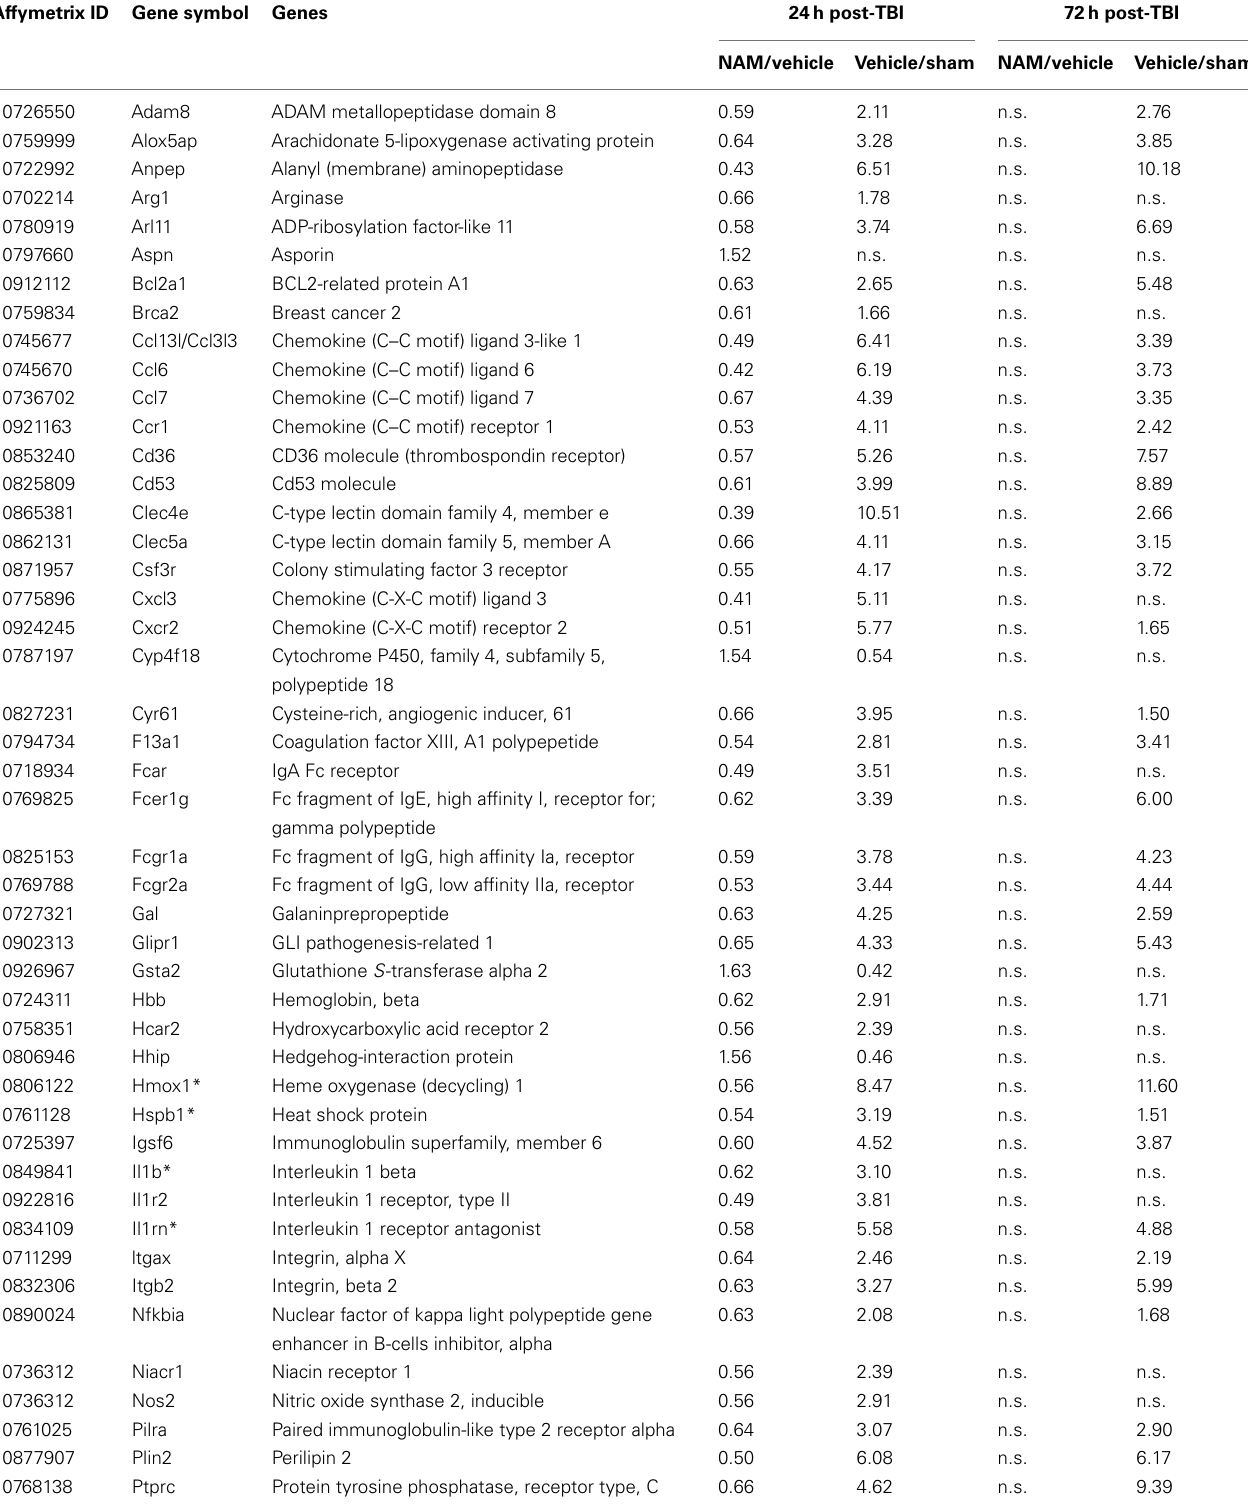
Table 4 |The effect of NAM treatment (NAM/vehicle) andTBI (vehicle/sham) on differentially expressed genes associated with significant functional categories and canonical pathways identified by IPA at 24h